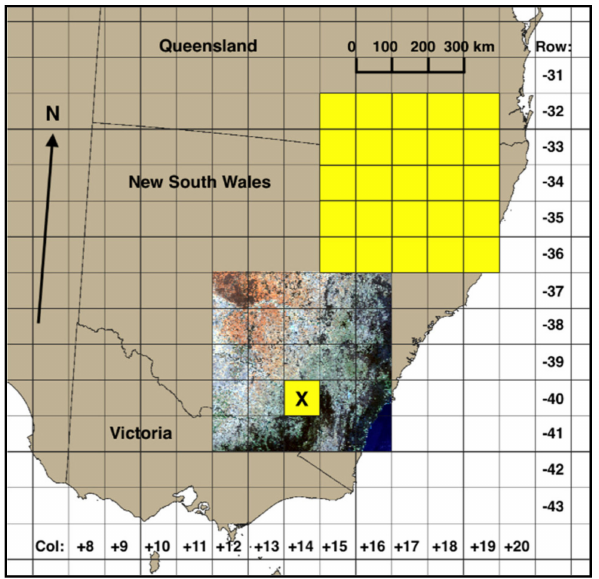
Figure 1. Study area (2018 Landsat 8 geomedian true colour RGB), test tile +14, − 40 (annotated with ‘X’) and northern test area in yellow. Projection: GDA94/Australian Albers (EPSG: